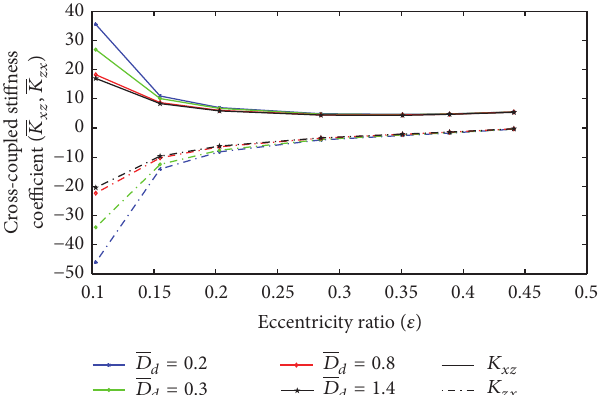
Figure 23: Effect of dam depth ratio on mass